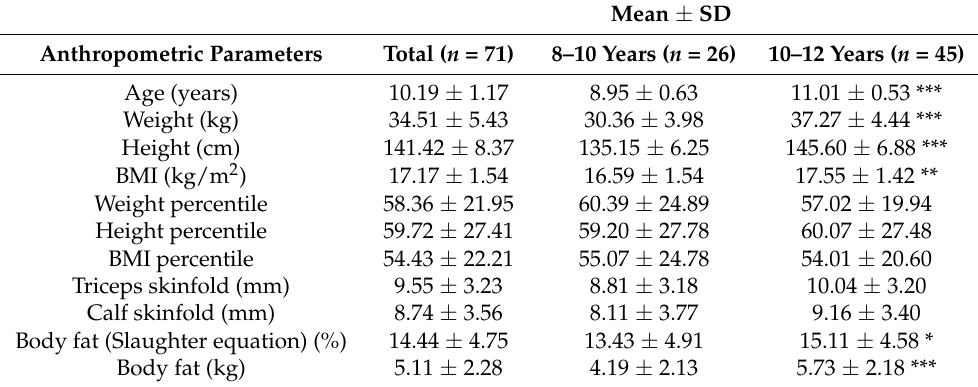
Table 2. Anthropometric parameters.